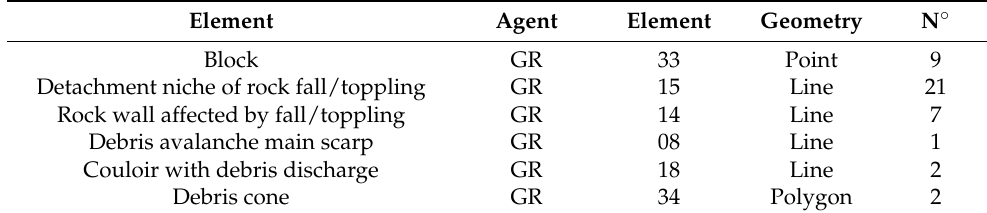
Figure 14. GOGIRA’s geomorphological map. Table 6. Total mapped elements after cleaning process. The “Agent” and “Element” fields are referred to the MARVIN setup (see Section